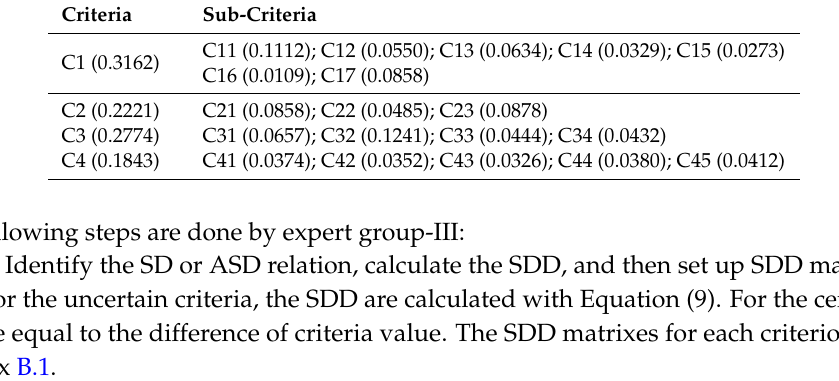
Table 7. The separation of each alternative from positive and negative ideal solution.